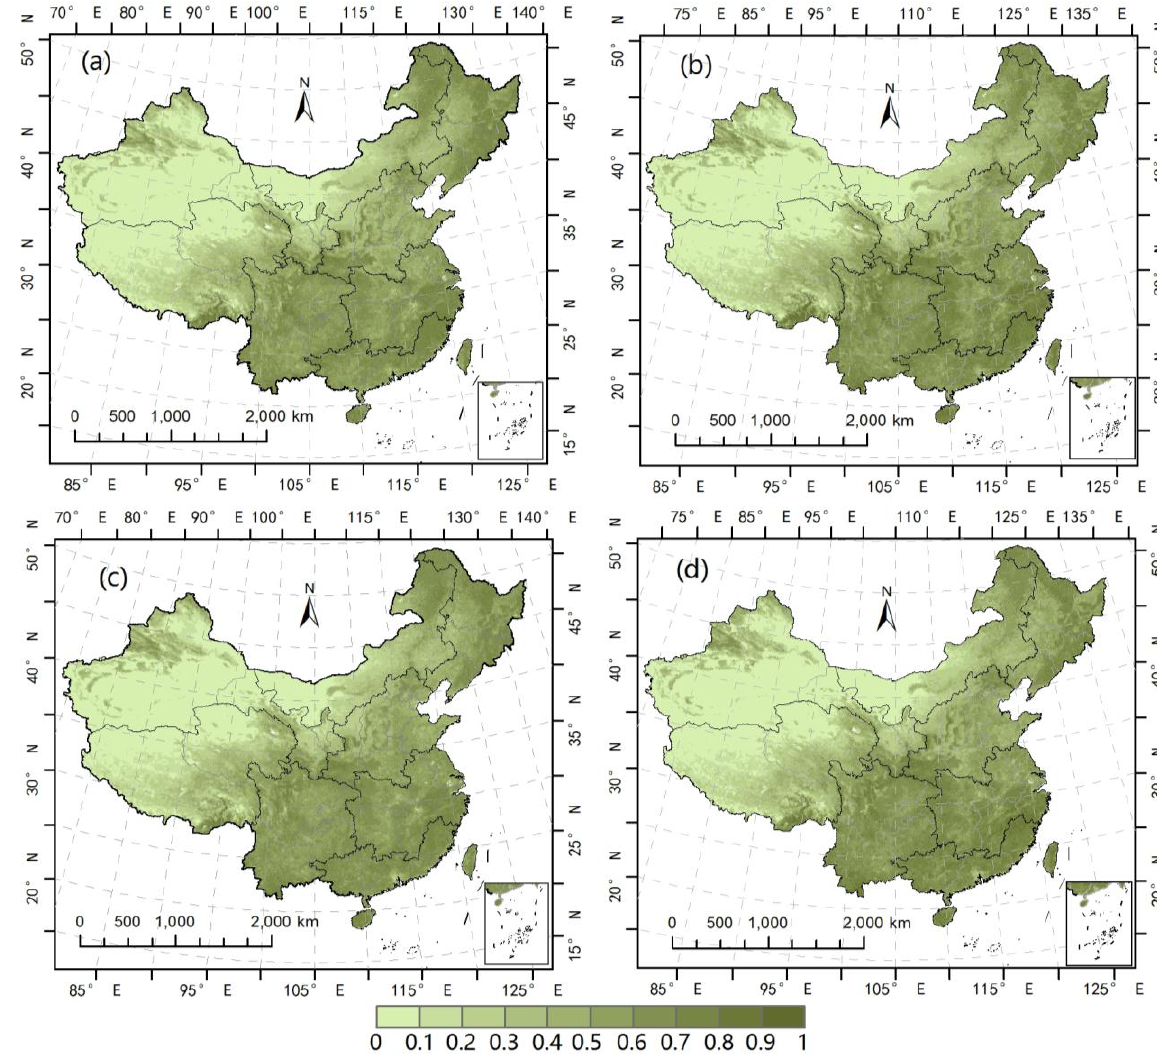
Figure 3. Spatial distribution of growing-season NDVI in 1982 ( a ), 1990 ( b ), 2000 ( c ), and 2011 ( d